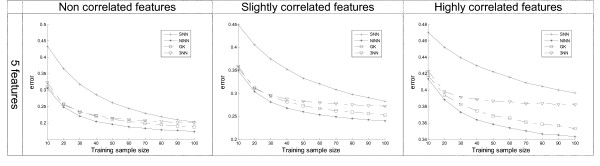
Comparison of various classifiers for bimodal model.